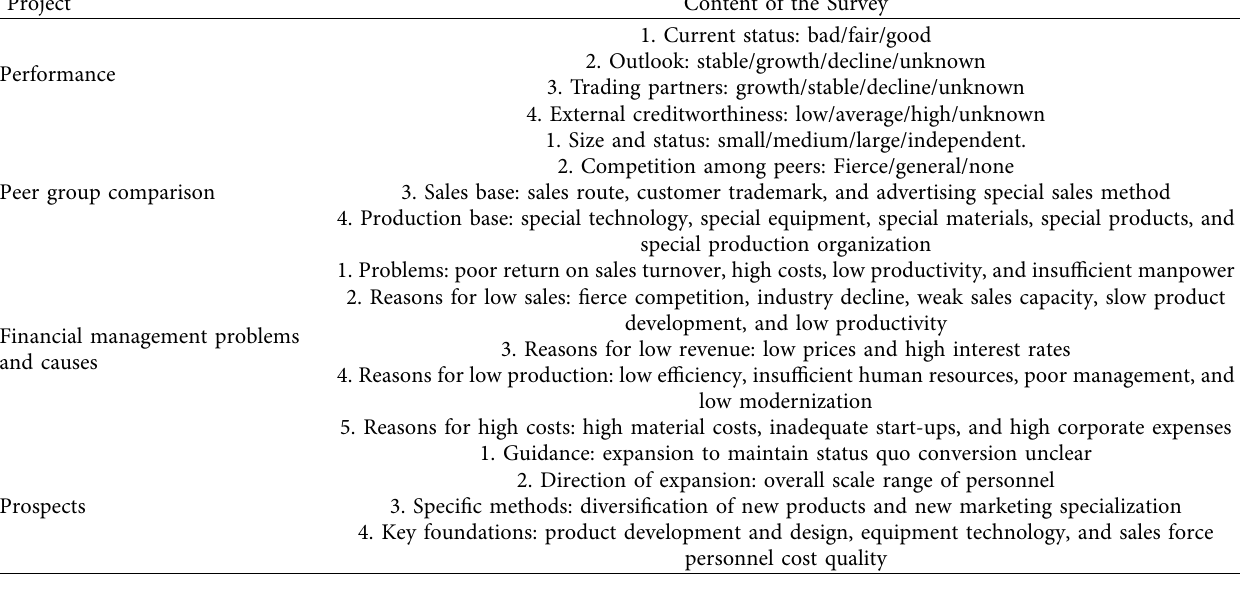
Table 1: Standardized questionnaire.